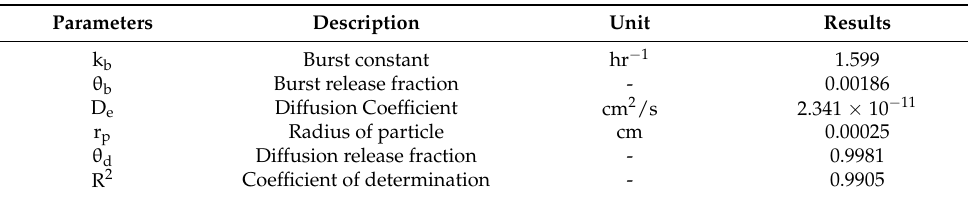
Table 4. Kinetics parameters extracted from the non-linear least-square fitting of the measured drug-release profiles of the ILDF particles using Equation